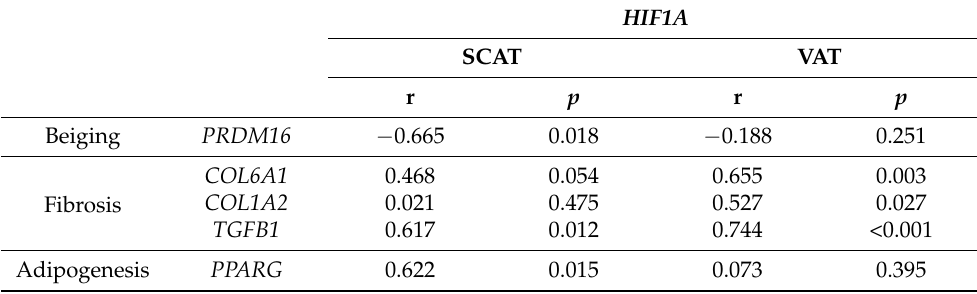
Table 1. Correlations (Pearson’s test) between HIF1A and beiging-, fibrosis- and lipid-related markers in vivo. Correlation between HIF1A gene expression and beiging-, fibrosis-, and lipid-related gene expression in SCAT and VAT from SIVART and control macaques. Correlations were determined using PCR data obtained using SCAT and VAT from six control uninfected and untreated macaques (Ctrl) and eight SIV-infected and ART-treated macaques (SIVART). HIF1A